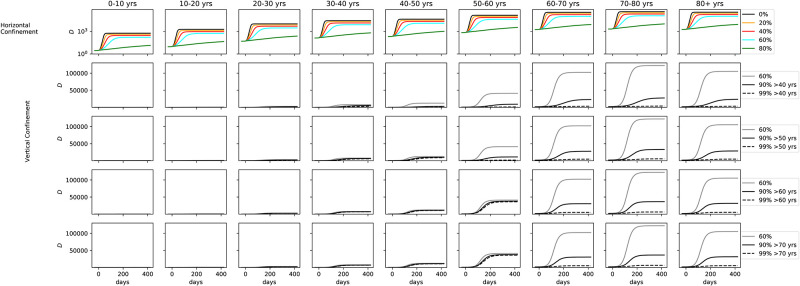
Same as Fig 7, but for the number of fatalities.